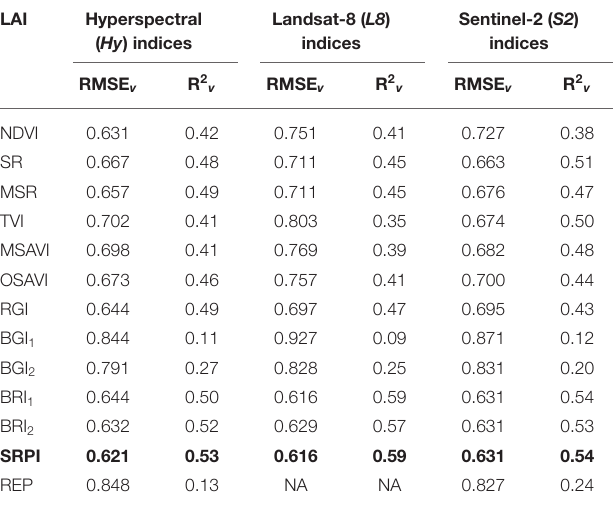
TABLE 8 | Validation statistics (RMSE v and R 2 v ) of simple linear regression models of Hyperspectral ( Hy ) indices, and synthesized Landsat-8 ( L8 ) and Sentinel-2 ( S2 ) indices obtained for dry biomass of finger millet.